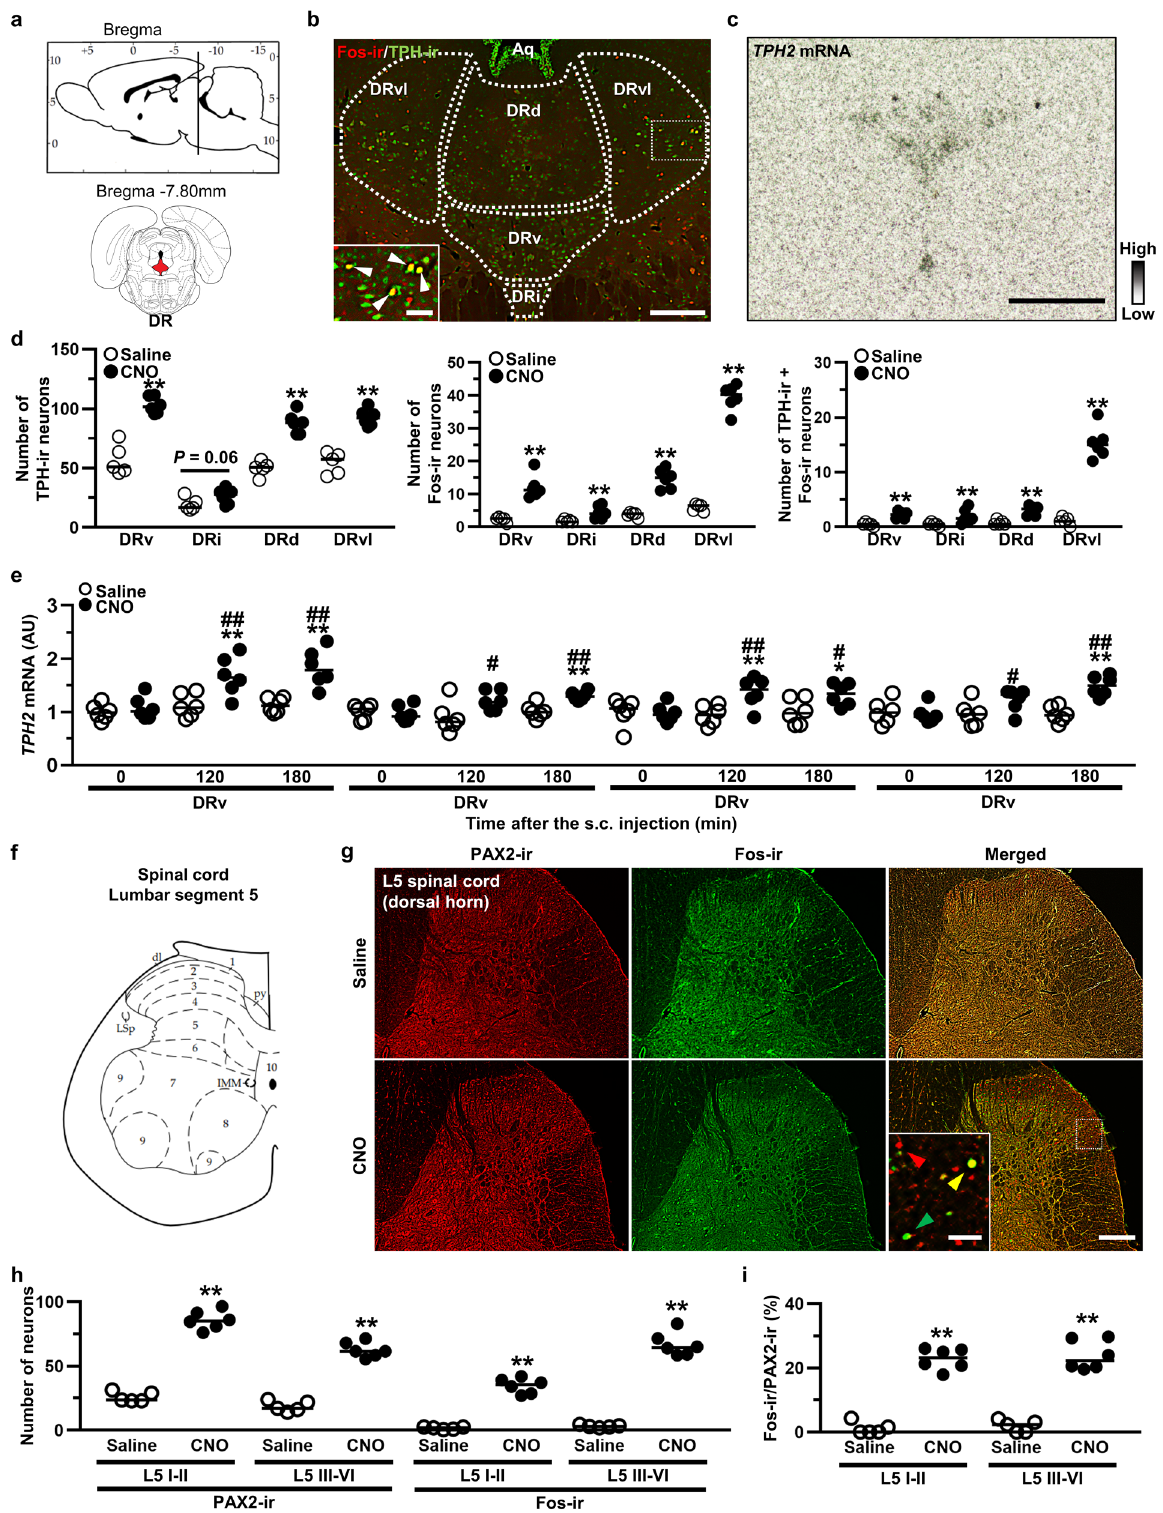
( n = 9 rats, each) (Fig.